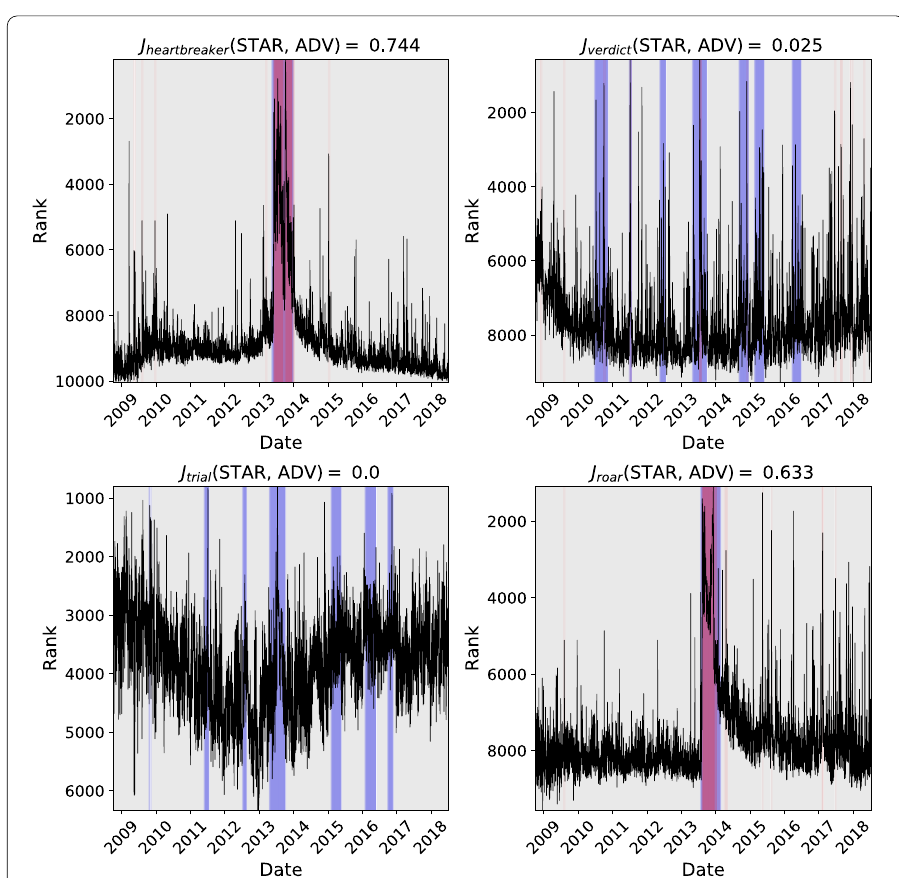
Figure 18 Heartbreaker. Comparison of STAR and ADV indicator windows for some words surrounding popular events (the release of a song called “Heartbreaker” by Justin Bieber and “Roar” by Katy Perry) and criminal justice-related events (the trial and acquittal of George